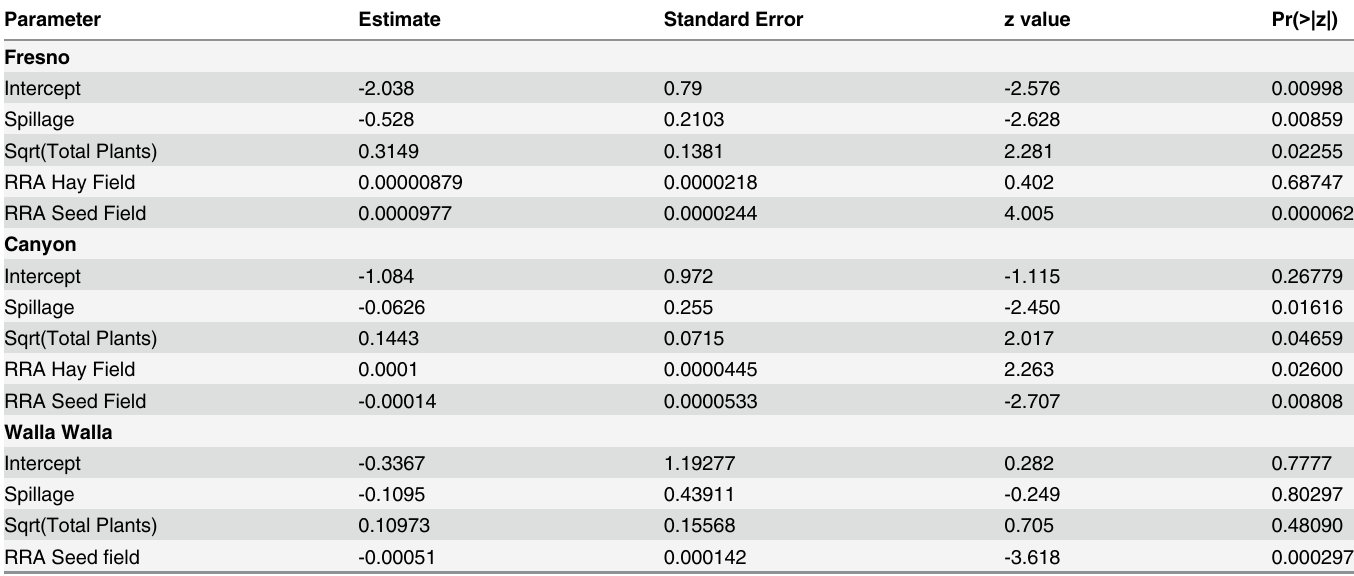
Table 5. Logistic regression model for the influence of spillage during production and transport, population size, and proximity to historic GR hay and seed fields on the occurrence of transgenic roadside alfalfa plants.